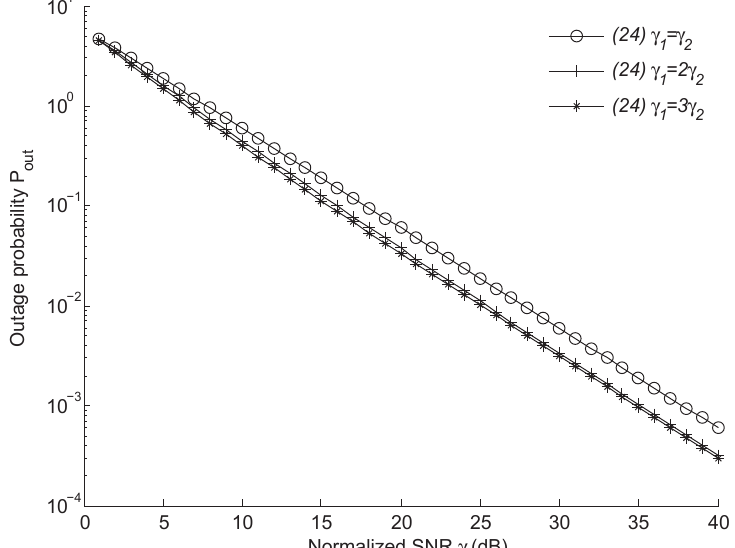
Figure 8. A comparison of the outage probability of AF relay-assisted vehicular networks based on Equation